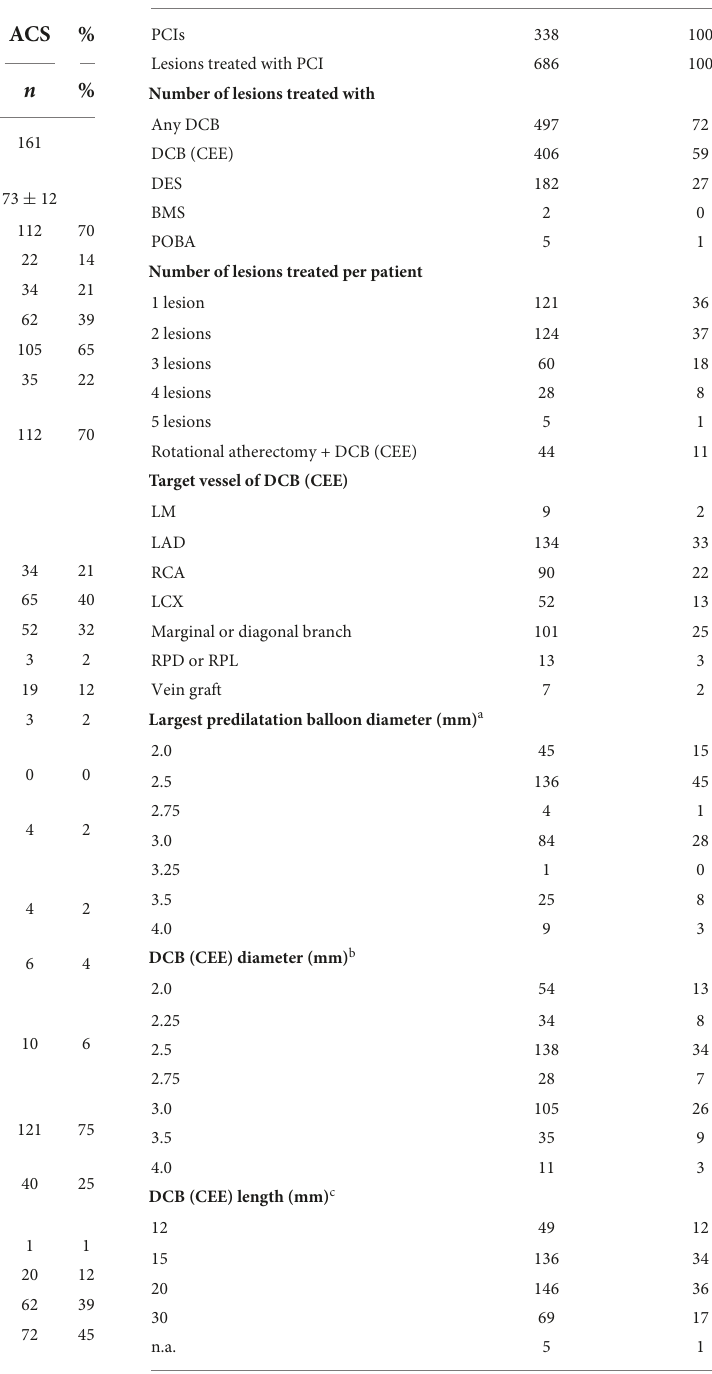
TABLE 1 Baseline characteristics of patients including risk factors, comorbidities, bleeding risk, acute coronary syndrome (ACS) and Canadian cardiovascular society (CCS) class as well as ejection fraction.